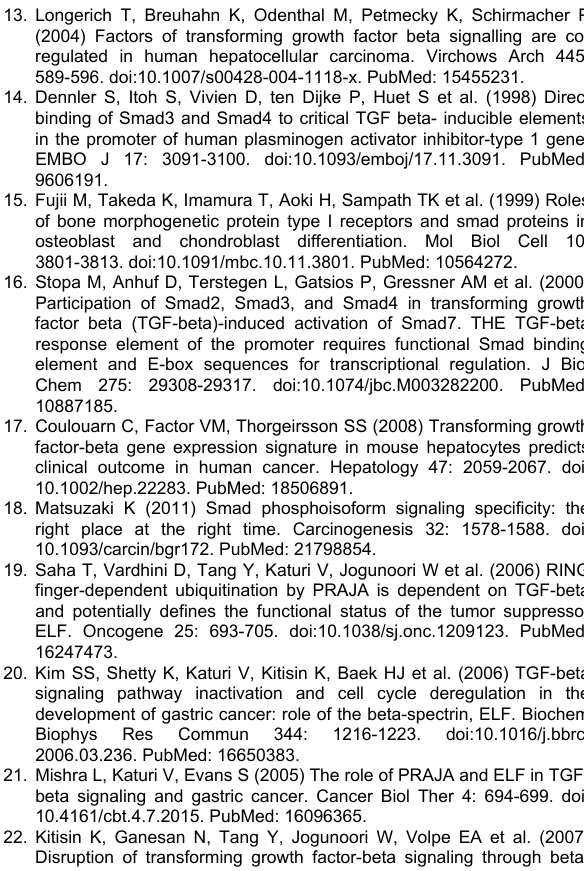
Figure S5. Densitometric Analysis (ImageJ software) of Western Blots in Figure 5 and corresponding repetitive experiments. Results are shown as mean +/- SE of the indicated numbers of independent experiments.